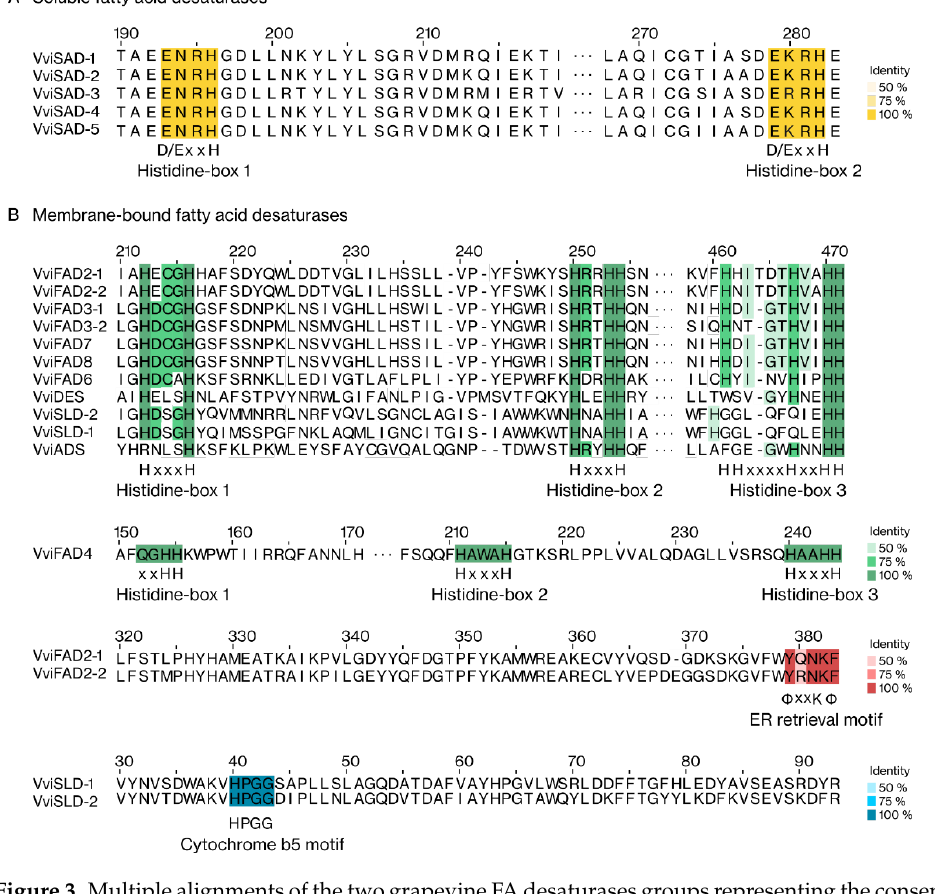
Figure 3. Multiple alignments of the two grapevine FA desaturases groups representing the consensus and conserved motifs. Protein sequences were aligned for each FA desaturase group separately, applying the MAFFT tool. The consensus motifs are shown in shadow boxes according to percentage identity. ( A ) soluble fatty acid desaturases; ( B ) membrane-bound desaturases.